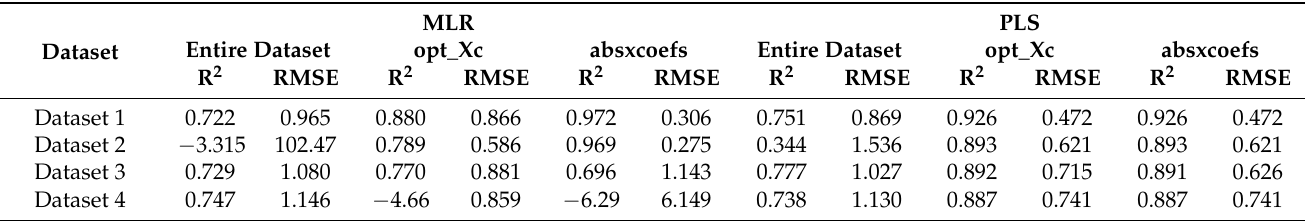
Table 3. Prediction scores for the TSS content of intact berries of Thompson seedless grapes, using a 90% of the spectra for PLS regression model training.